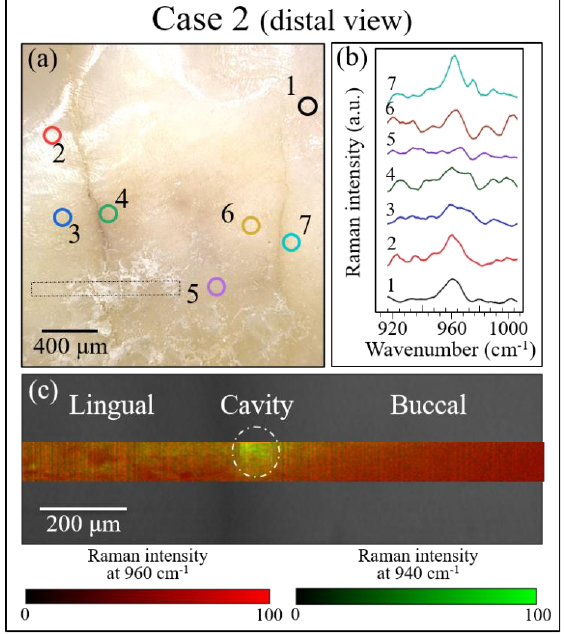
Figure 9. Raman analysis of the tooth sample in Case 2: ( a ) optical image (100× lens) showing locations (1~7) selected for point analysis, ( b ) recorded Raman spectra (10× lens) at the selected locations (cf. labels) in the spectral region around 960 cm − 1 , and ( c ) Raman map corresponding to the area indicated by the rectangular inset in ( a